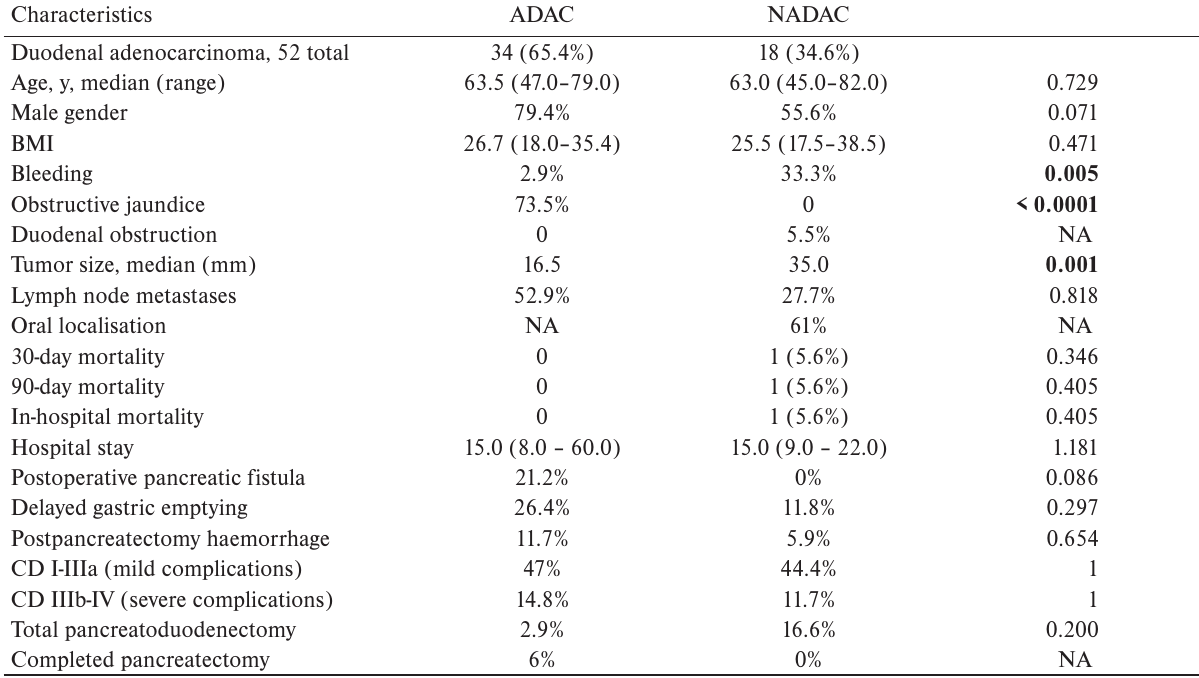
Table 1. Demographic, clinical and procedural characteristics of the study population.